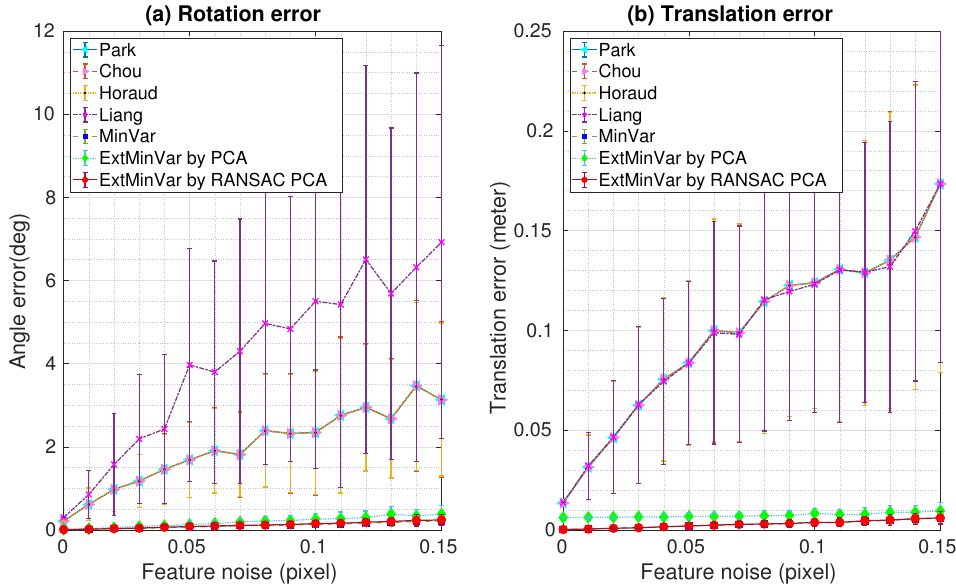
Figure 8. Experimental results using synthetic data with feature noise [0–0.15 pixel]: ( a ) Rotation error; ( b ) Translation error.